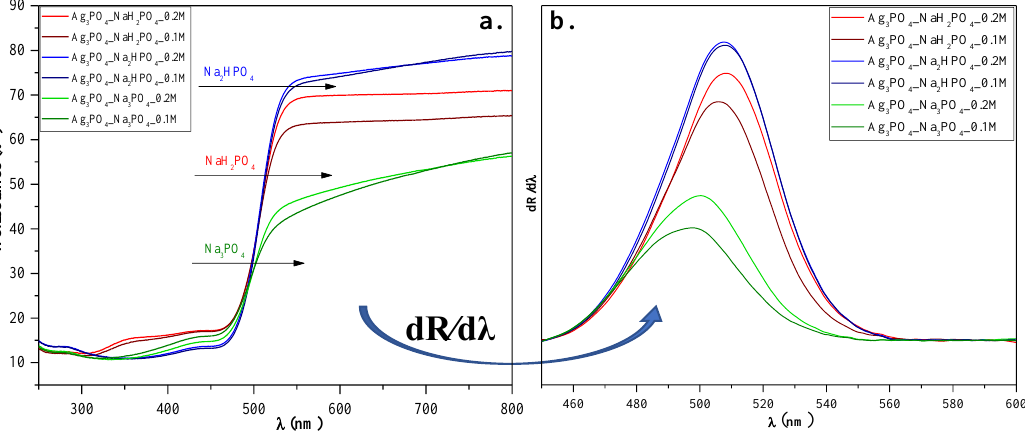
Figure 4. ( a ) Diffuse reflectance spectra and ( b ) their first derivative order of Ag 3 PO 4 samples synthesized by using different types (Na 3 PO 4 , Na 2 HPO 4 , and NaH 2 PO 4 ) and concentrations of phosphate sources (C = 0.1 and 0.2 M).